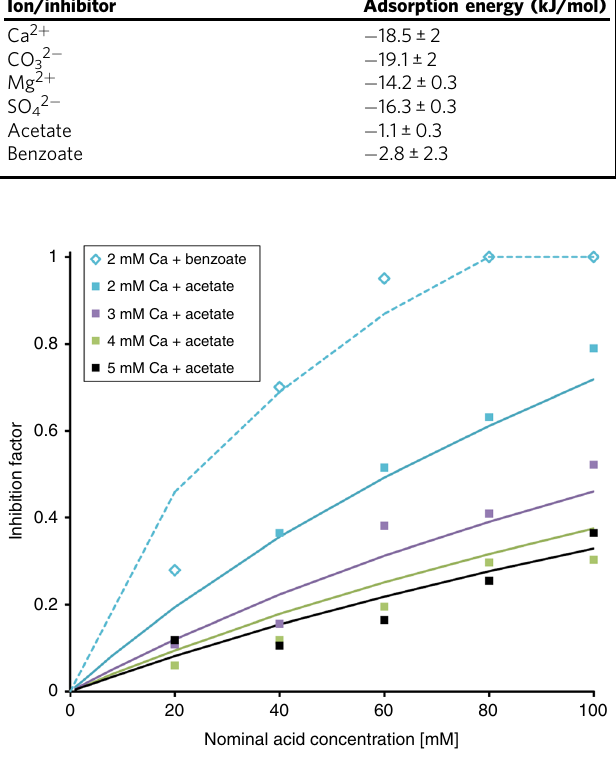
Fig. 3 Comparison between the model and the experimental growth inhibition data for acetate and benzoate. The inhibition factor for calcite growth in the presence of the small carboxylate anions, acetate ( fi lled squares) and benzoate (open diamonds). In the legend, x mM Ca refers to a starting solution of x mM CaCl 2 and x mM NaHCO 3